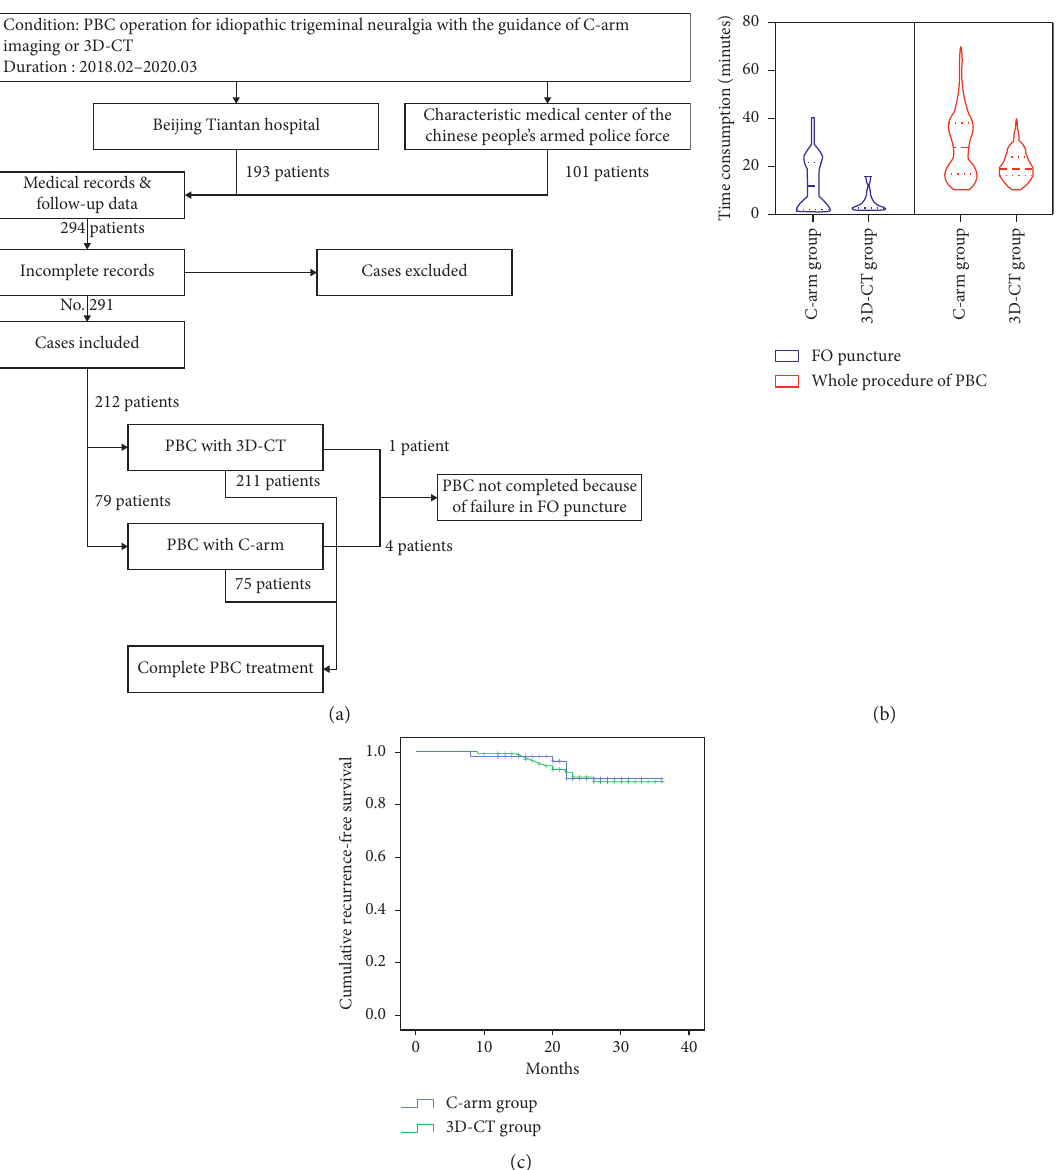
Figure 3: Summary of study results. (a) Plot of patient selection procedure; (b) time consumption of FO puncture and whole procedure of PBC; (c) Kaplan–Meier curves of recurrence-free survival of both